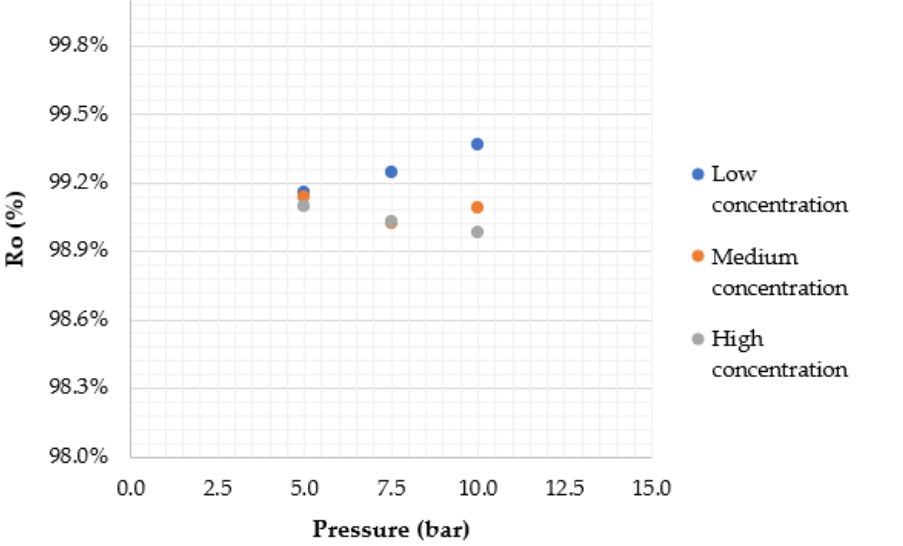
Figure 7. Influence of the applied pressure on Pb salt rejection (feed flow = 0.39 to 0.55 m 3 /h, feed concentration = 3.5, 16, and 32 mol/m 3 ).